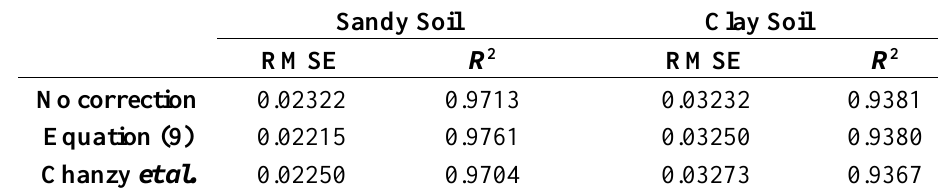
Table 4. Results from the comparison between ε correction models based on